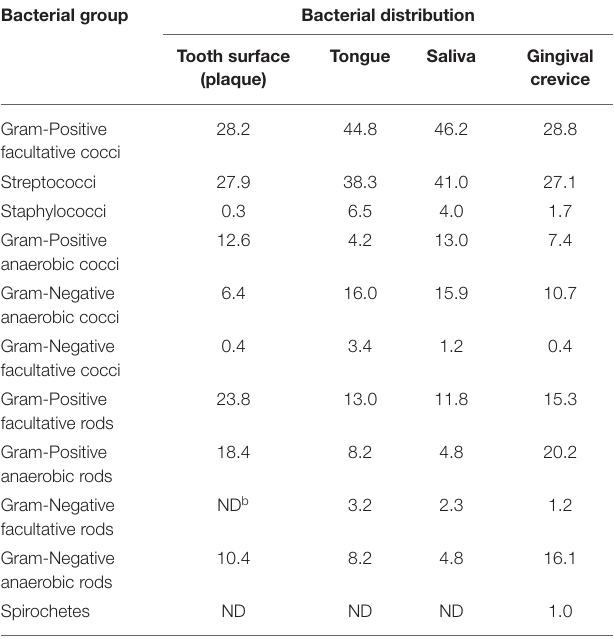
TABLE 2 | Flora site and bacterial distribution in the human oral cavity a